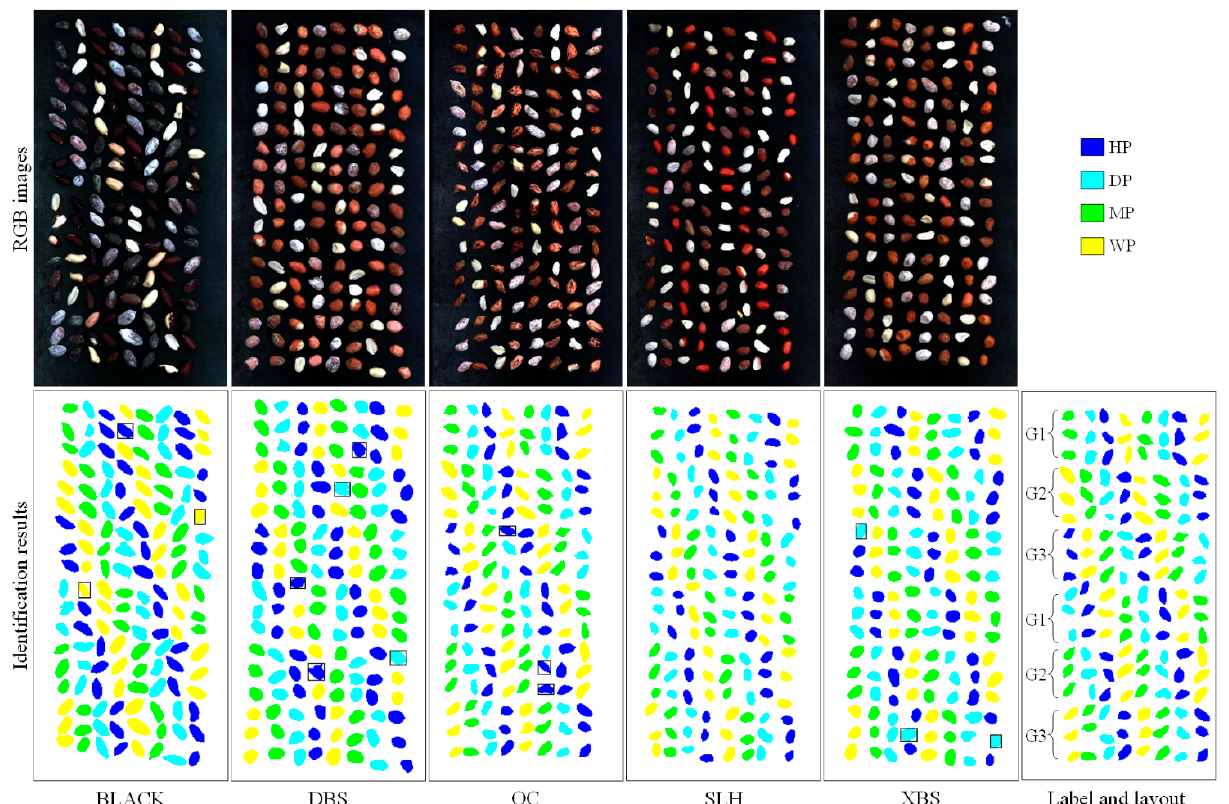
Figure 7. Visualization of classification results. BLACK, Black peanut; DBS, Dabaisha; QC, Qicai; SLH, Silihong; XBS, Xiaobaisha; HP, healthy peanuts; DP, damaged peanuts; MP, moldy peanuts; WP, white moldy peanuts; G1, the first moisture content gradient; G2, the second moisture content gradient; G3, the third moisture content gradient.